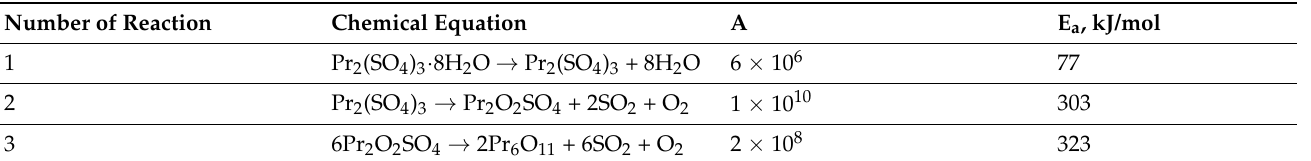
Table 5. Kinetic parameters of the decomposition of praseodymium